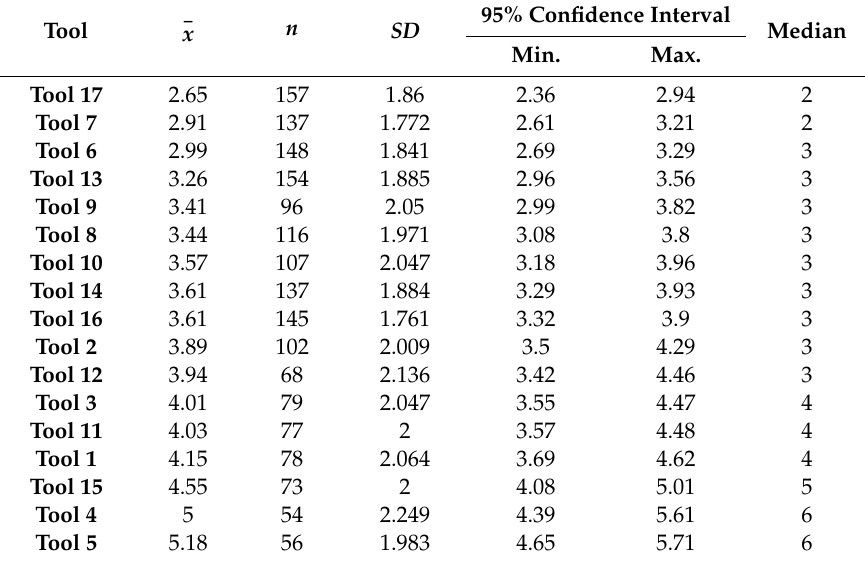
Table 1. Evaluation of innovative marketing